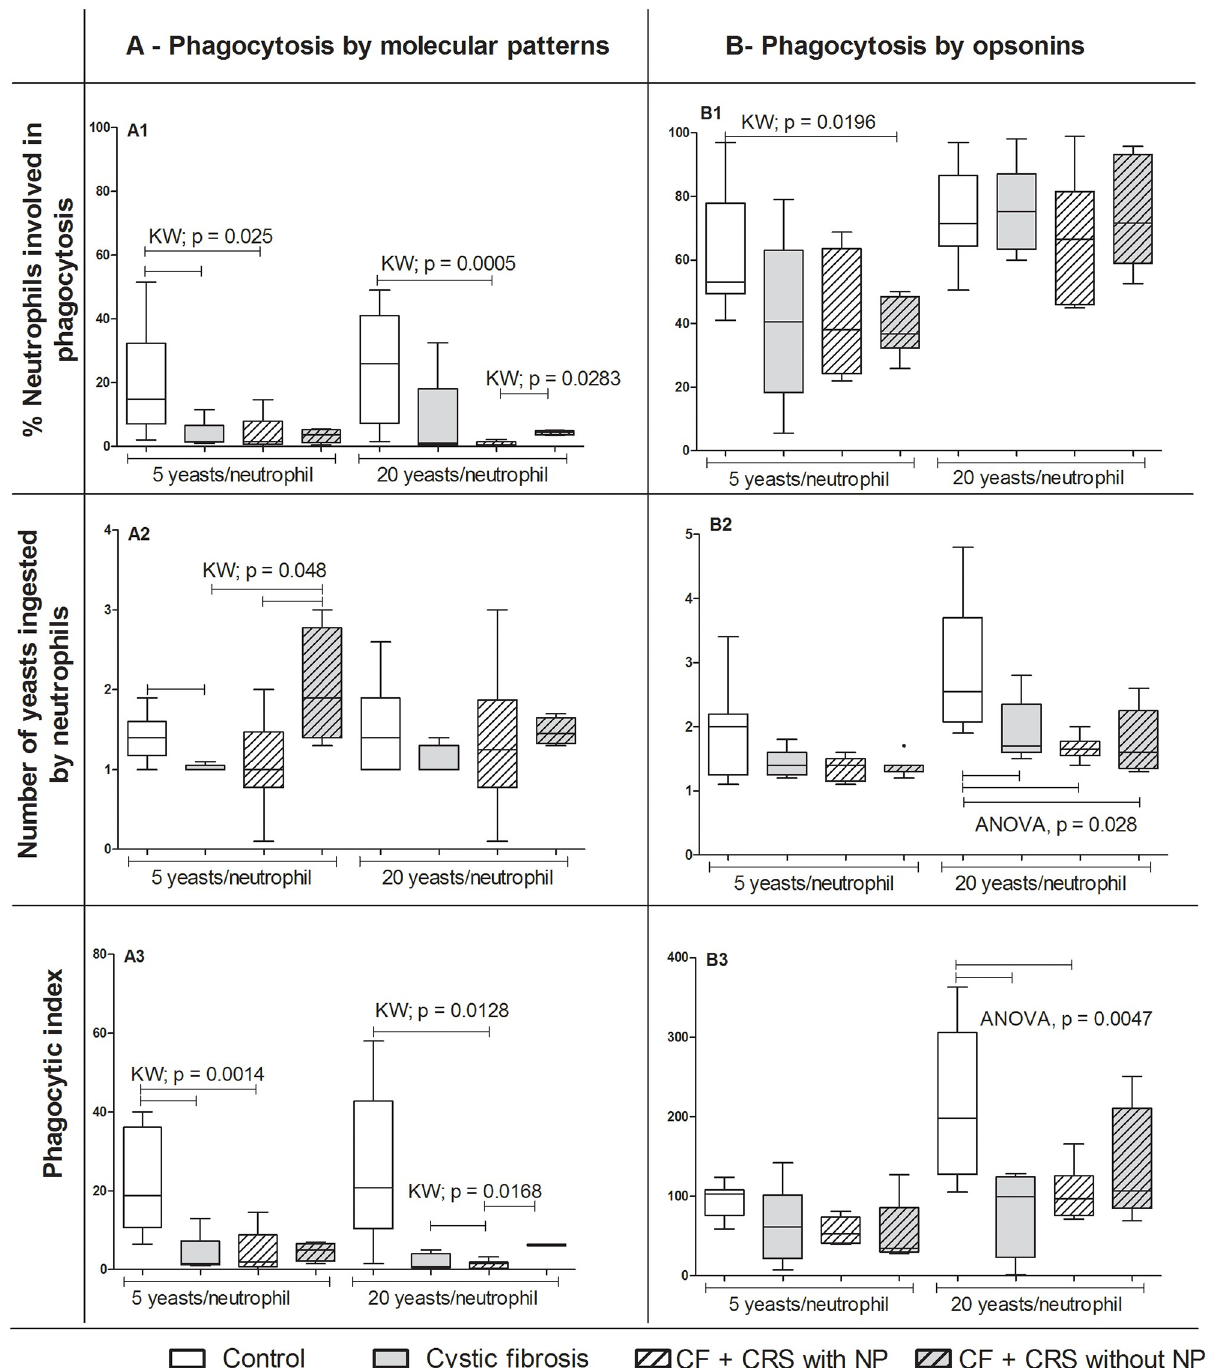
Fig 1. Phagocytosis by neutrophils. Phagocytosis of Saccharomyces cerevisiae cells by pathogen-associated molecular pattern A) and opsonin receptors (B) by blood peripheral neutrophils in children. Groups: cystic fibrosis (CF) n = 6; cystic fibrosis plus chronic rhinosinusitis and presenting nasal polyps (CF+CRS with NP) n = 6; cystic fibrosis plus chronic rhinosinusitis but without nasal polyps (CF+CRS without NP) n = 5; control group (n = 14). In the top, % of neutrophils involved in phagocytosis, in the middle, number of yeasts ingested by neutrophils and in the bottom phagocytic index. Significant results are shown by bar between groups. Values are presented as the median, quartiles, maximum, and minimum values. KW = Kruskal- Wallis.